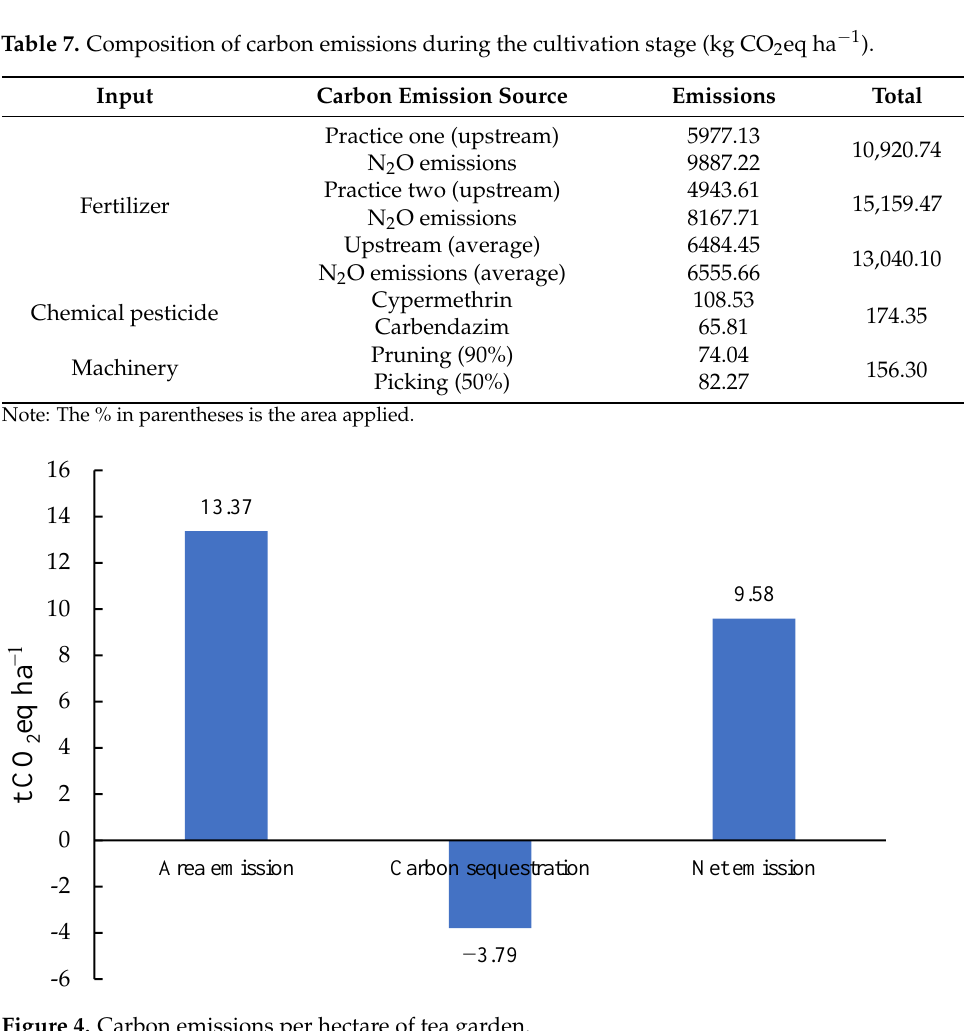
Table 7. Composition of carbon emissions during the cultivation stage (kg CO 2 eq ha − 1 ).